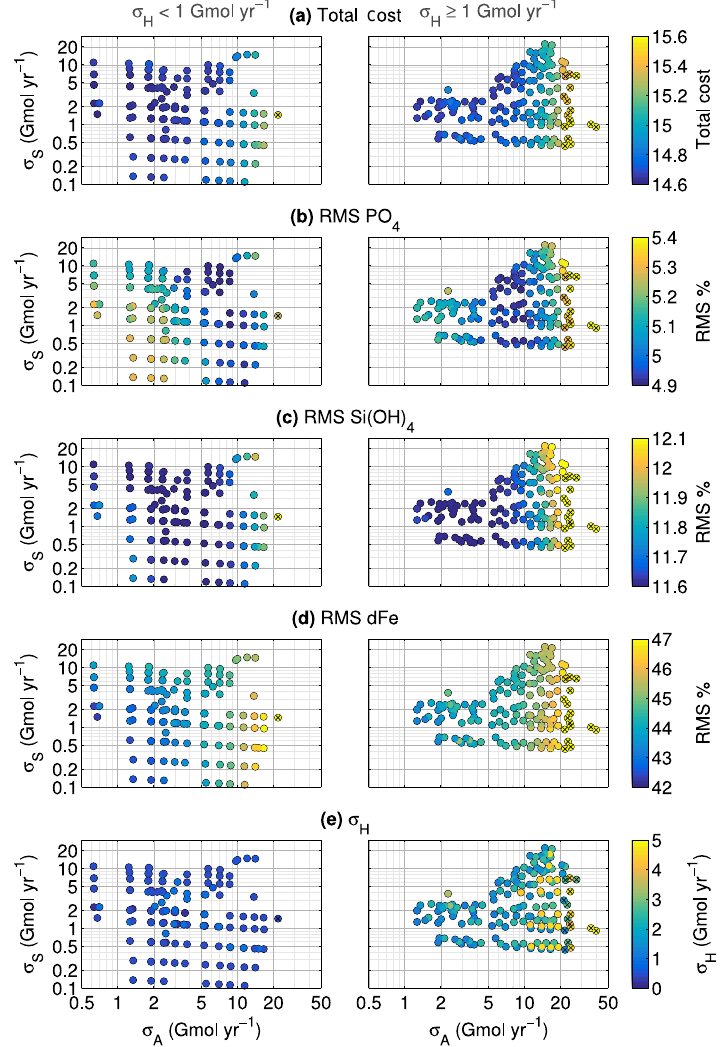
Figure 1. Total cost metric and rms mismatch of the nutrient concentrations as a function of the aeolian, hydrothermal, and sedimentary iron source strengths ( σ A ,σ S ,σ H ) plotted for all our optimized state estimates. State estimates with a total nondimensional cost that exceeds 15 . 4 are indicated by black crosses and were excluded from our family. Plots on the left show state estimates for which σ H < 1Gmolyr − 1 , while for plots on the right σ H ≥ 1Gmolyr − 1 . (a) Square root of the total cost expressed as a nominal percentage representative of the mean rms mismatch of the nutrient and phytoplankton concentrations. (b) Rms mismatch of the PO 4 concentration as a percentage of the global mean PO 4 concentration. (c) As (b) but for Si ( OH ) 4 . (d) As (b) but for dFe. (e) The value of the hydrothermal source σ H for each family